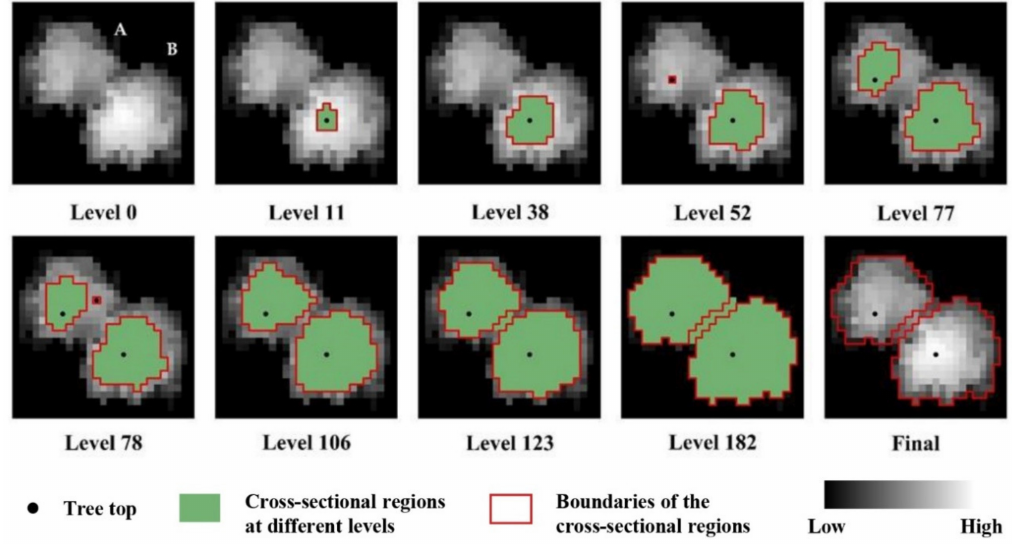
Figure 3. Schematic diagram of the region-based hierarchical cross-section analysis (RHCSA) algorithm based on a canopy height model (CHM) containing tree A and tree